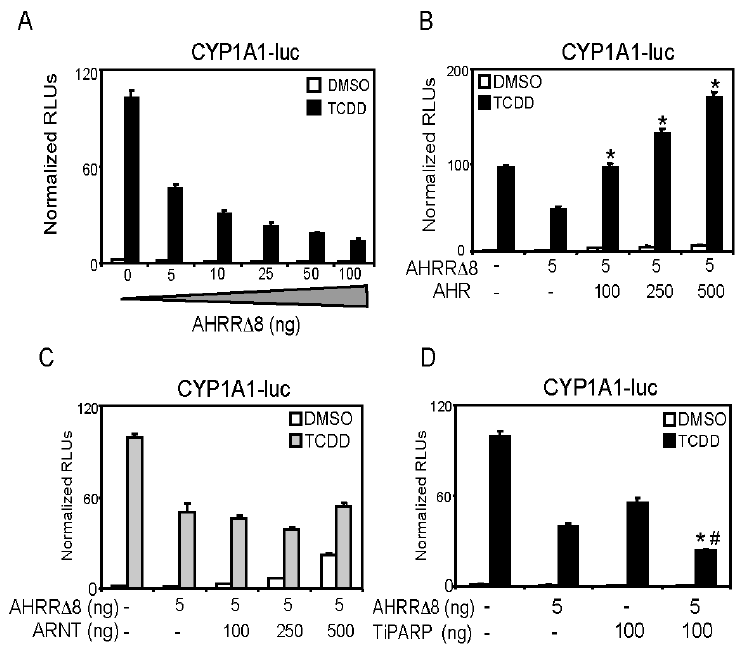
Figure 2. AHRR Δ 8 or TiPARP repress CYP1A1-regulated reporter gene activity.